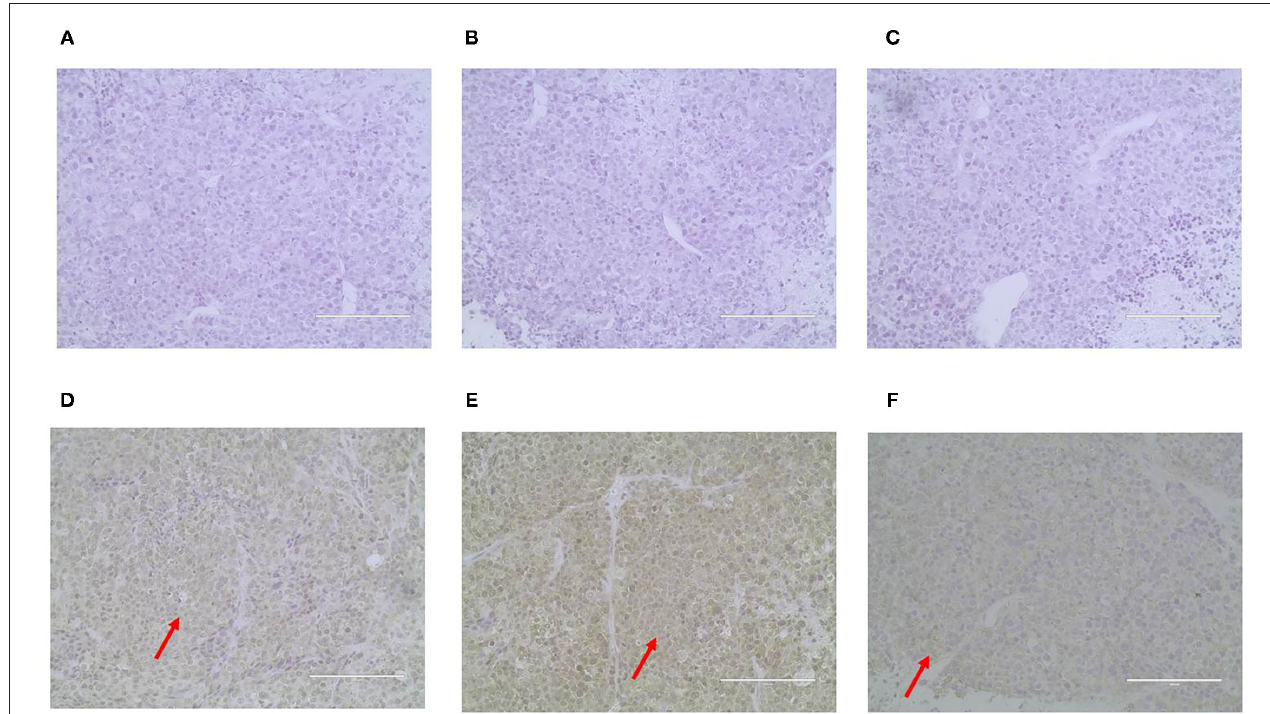
FIGURE 10 | Immunohistochemical staining of the xenograft tumor sections (400X). Dark brown color was observed as positive staining. Tissues from xenograft tumors were negative for ER (A) , PR (B) and HER-2 (C) , and were positive for P63 (D) , CK5/6 (E) , and α -SMA (F) localized in the cell membrane.